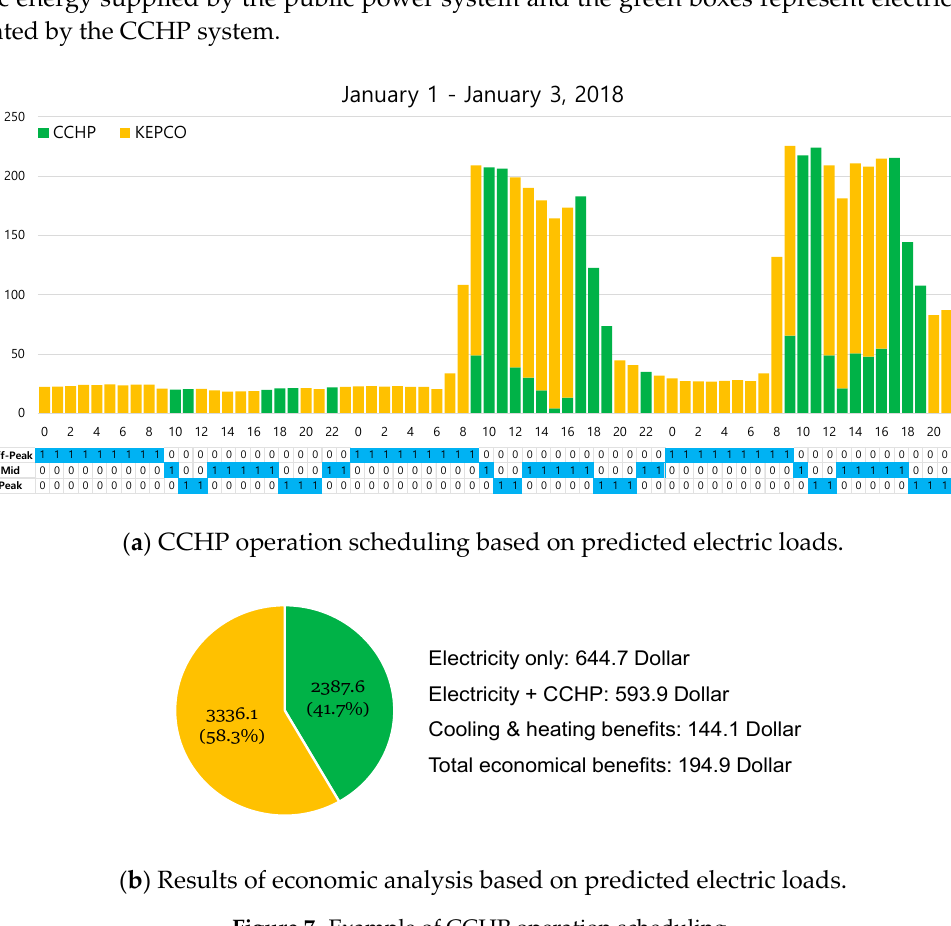
Figure 7. Example of CCHP operation scheduling.